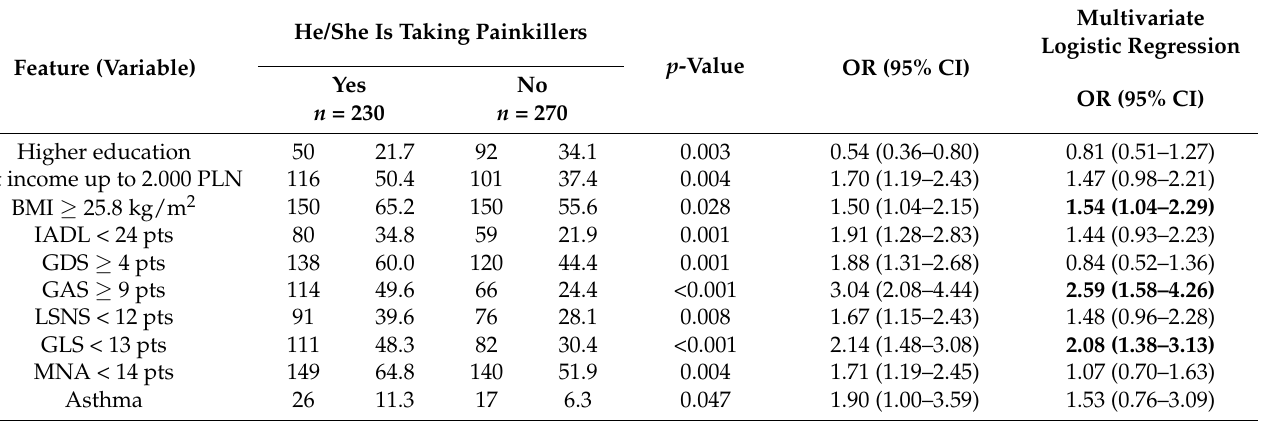
Table 7. Sociodemographic, clinical and mental characteristics in groups that differ in pain medication intake and test results.